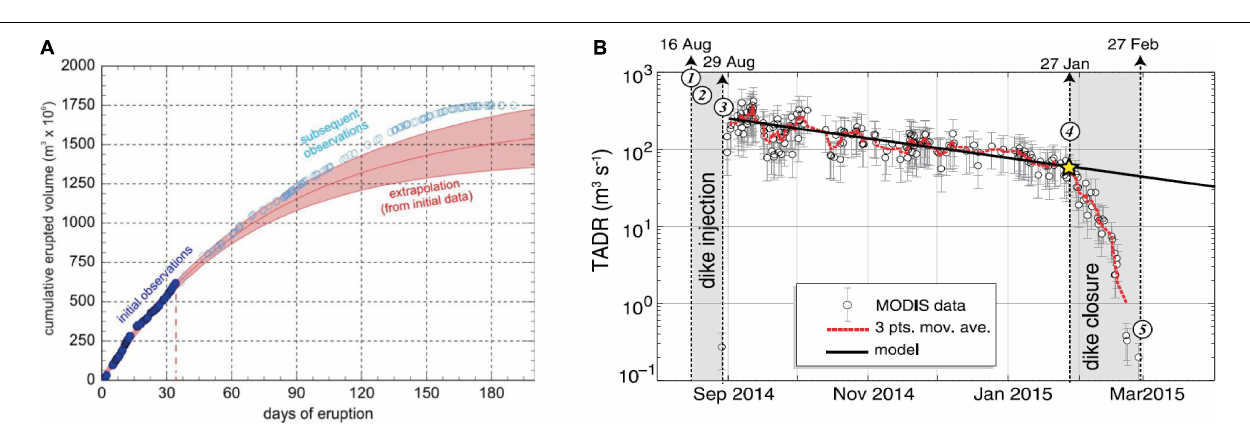
FIGURE 9 | (A) Extrapolation of the cumulative erupted volume during the Holuhraun 2014–2015 eruption, based on the initial 5 weeks of observations (modified from Tarquini et al., 2019), (B) Time-averaged lava discharge rate (TADR) measured during Holuhraun eruption (Iceland) (black circles; modified from Coppola et al., 2017) shows exponential decay of effusive activity. Departure from exponential trend began on 27 January 2015 and preluded the end of the eruption on 27 February. The yellow star indicates the critical flow rate Qc of ∼ 50 m 3 s − 1 when dike started to close. Numbered circles indicate main steps of eruption: (1) start